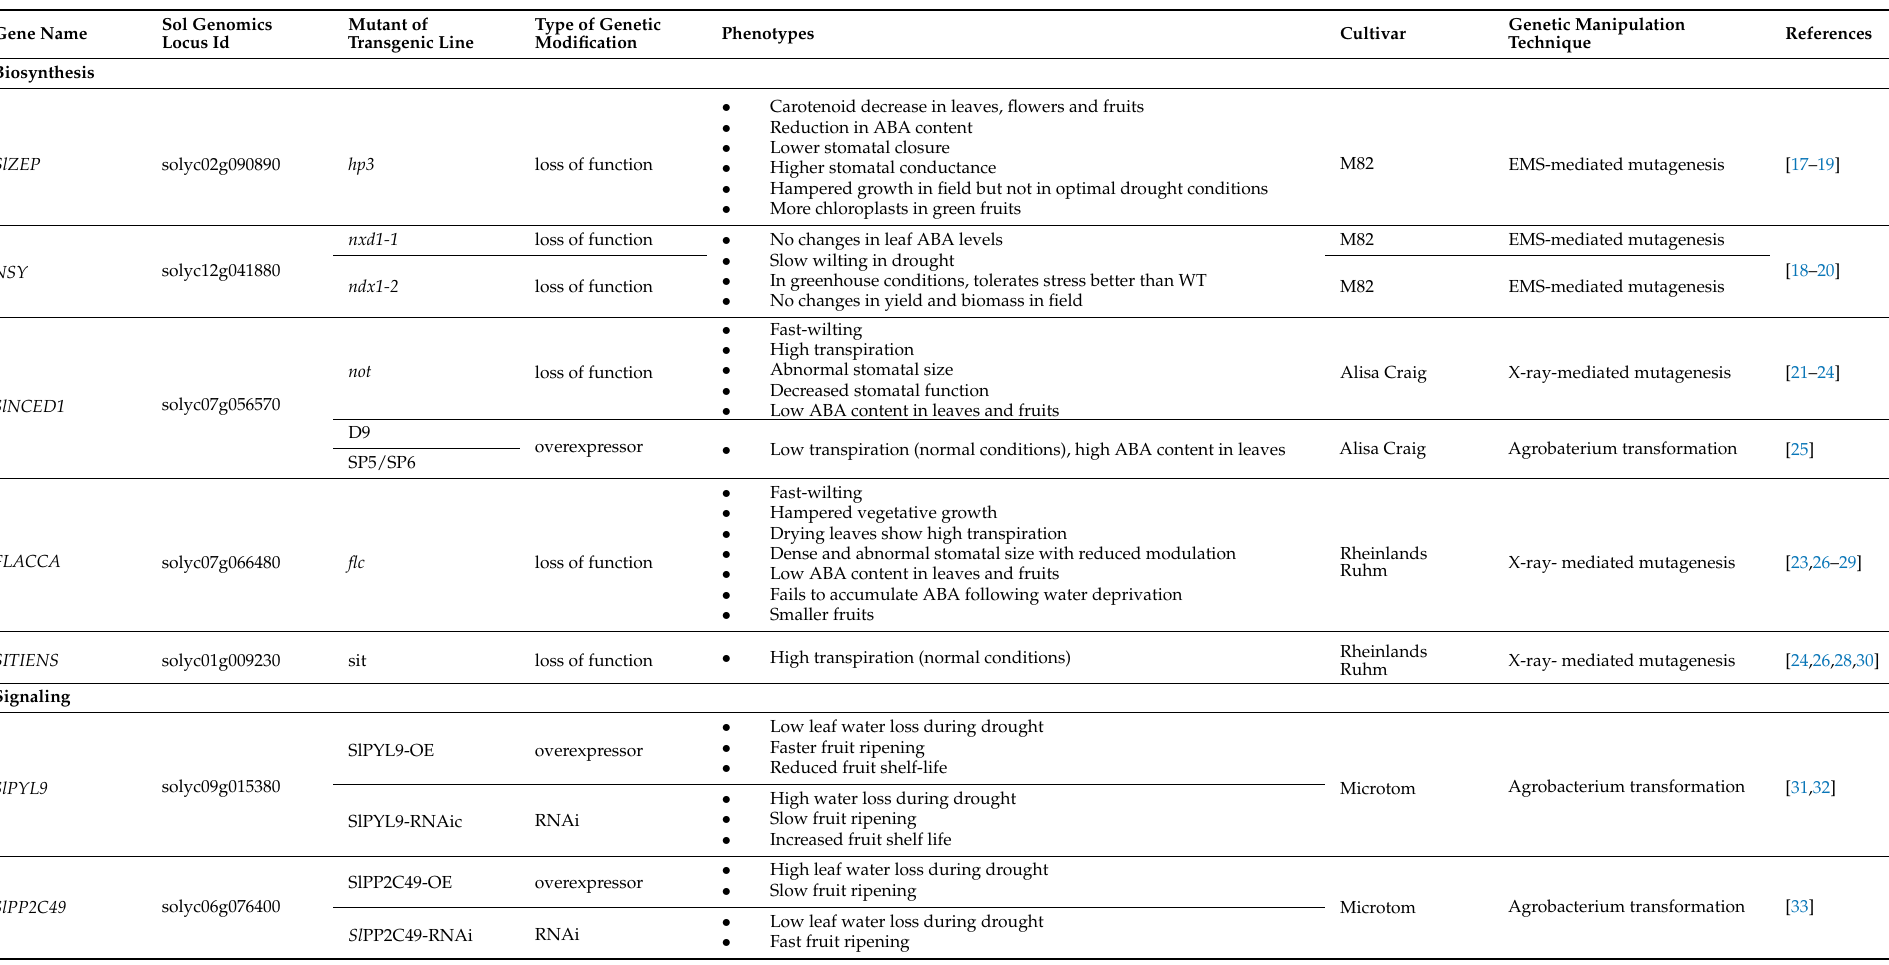
Table 1. Tomato ABA biosynthesis and signaling-related mutants and transgenic lines. The table summarizes mutants and transgenic lines described in the review. For each manipulated gene, we provide the following: gene name, Sol Genomics locus ID, name of the mutant or transgenic line (according to references), type of modification (i.e., loss of function, overexpressor, RNAi), discussed phenotypes, line cultivar, genetic manipulation technique, and